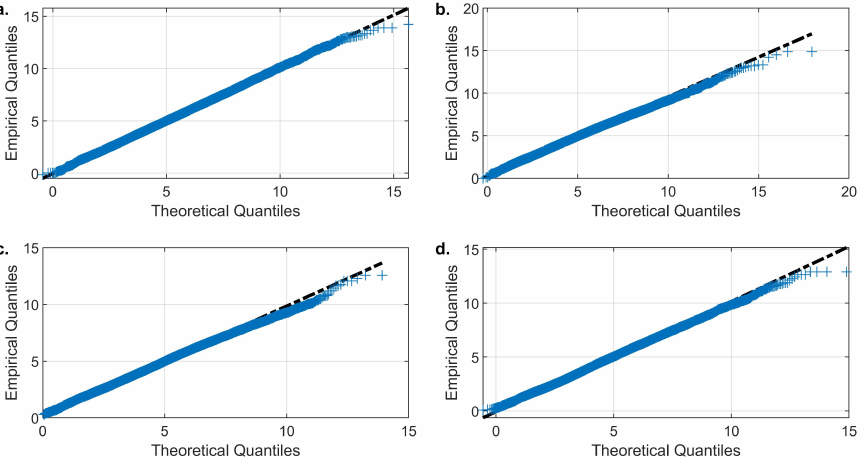
} , ( b ) La Grande { Y 2 t